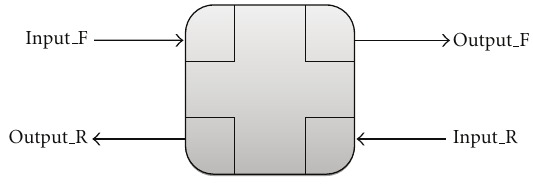
Figure 3: Systolic sorter cell interface.